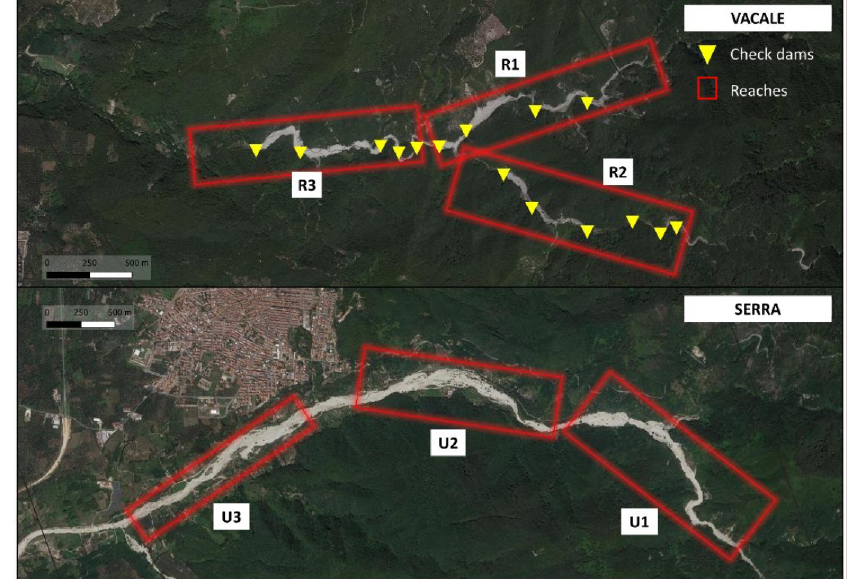
Figure 4. Location of the studied reaches (“RX” and “UX,” red boxes) selected in the Vacale and Serra sub-catchments (Calabria, Southern